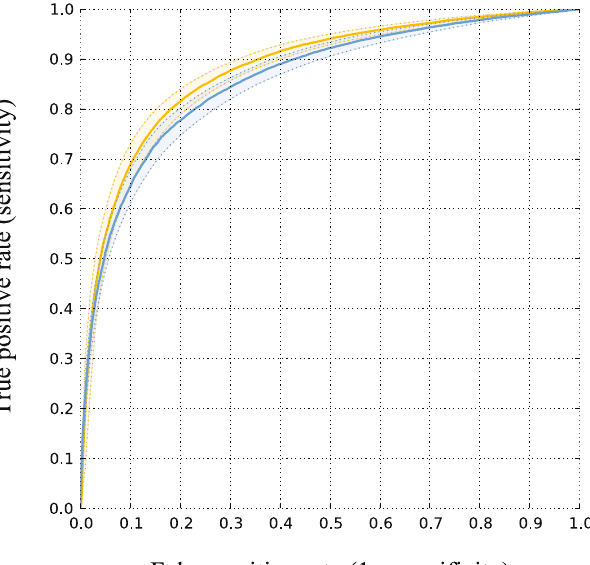
Figure 1. ROC curves of cross validation with the full feature set (yellow) and without the temporal image features (blue). Areas under the curves are 0.88 and 0.86 ( p < 0.0001),